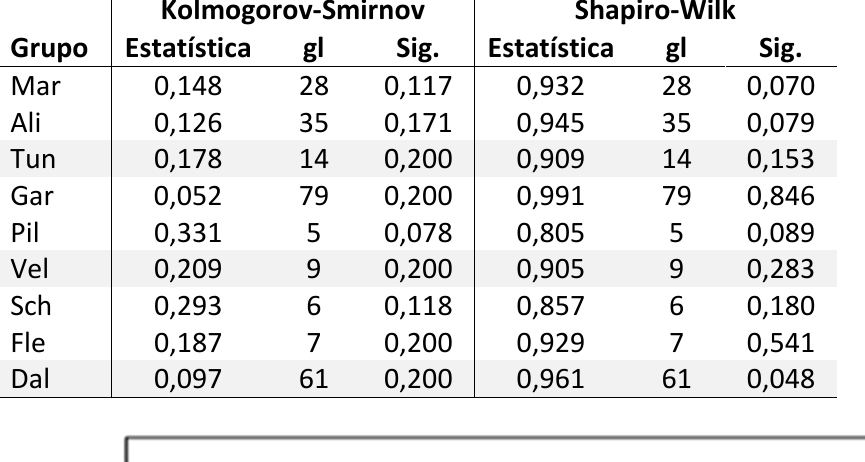
Table 3. Shapiro-Wilk and Kolmogorov-Smimov tests. Significant differences were considered at level 0.05 ( gl : degrees of freedom).